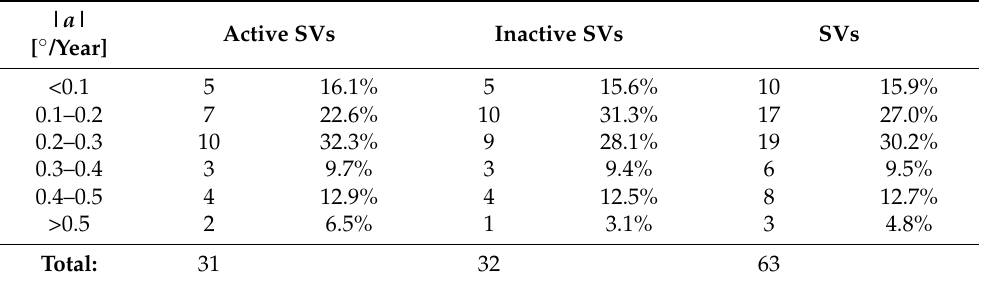
Table 3. Absolute values of the GPS satellite separation trends.